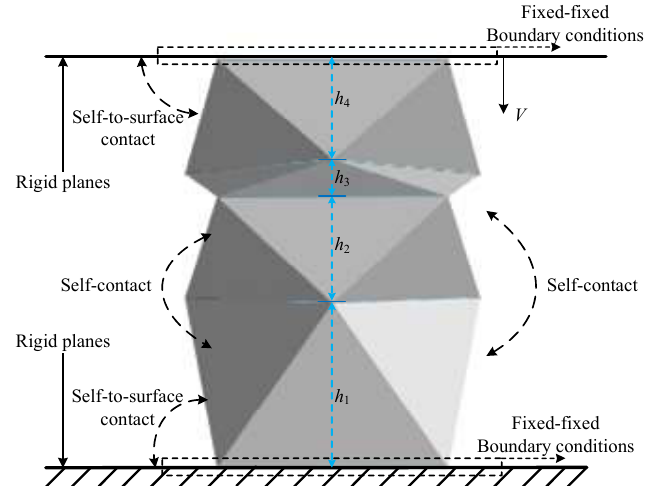
Figure 4. Representative finite element model.